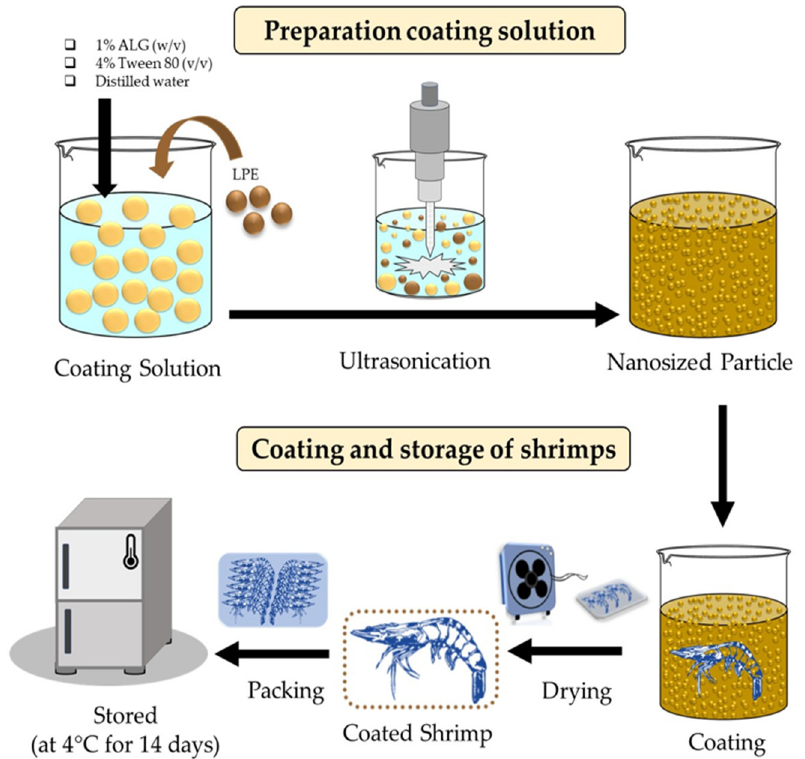
Figure 1. Schematic illustration of nanoparticle formation using ultrasonication and coating of shrimp using the LPE-added alginate-based nanoparticle edible coating.